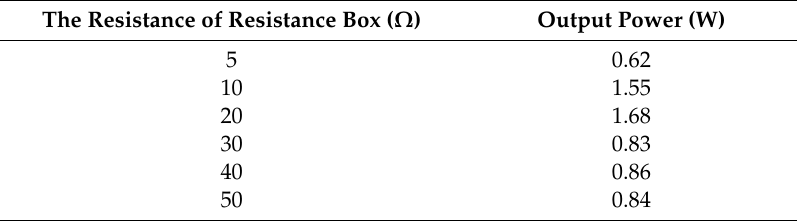
Table 5. Output power with di ff erent